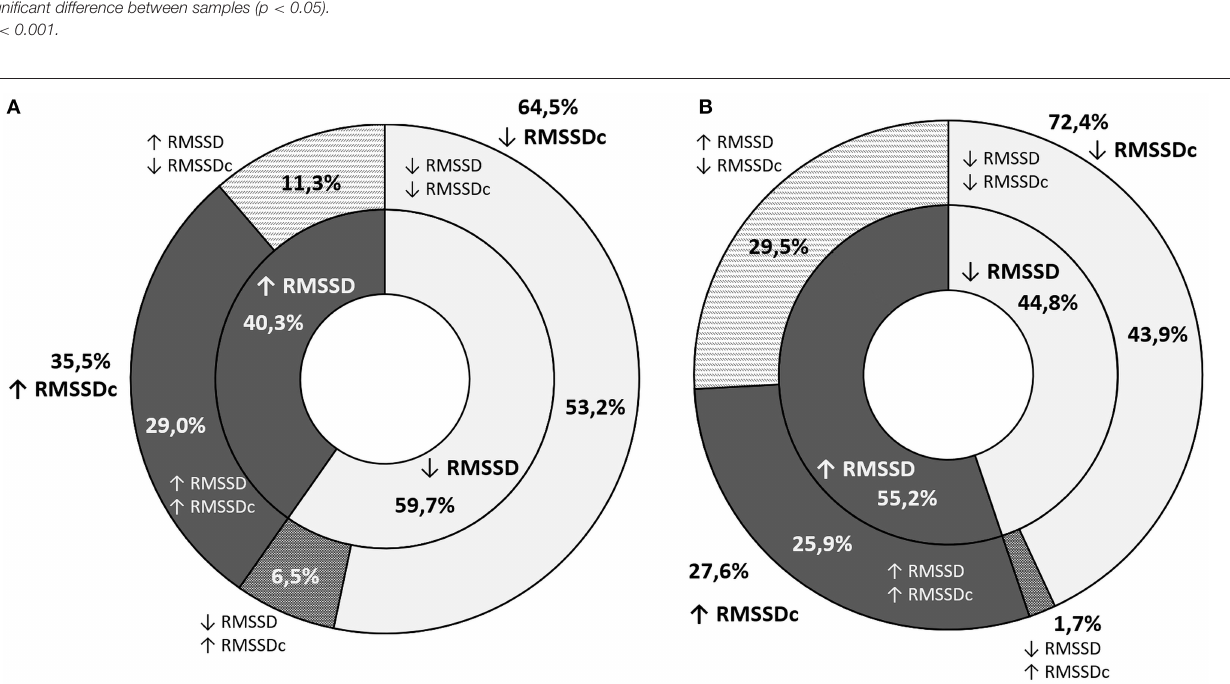
equivalent was lower after 3 years in 11.3% of boys and